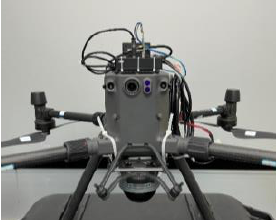
Figure 6 . Our UAV with LiDAR and IMU sensors